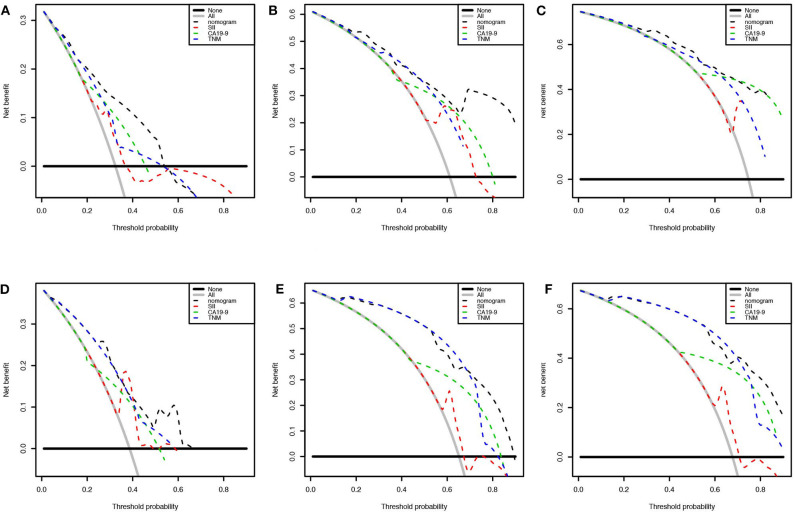
Decision curve analysis presented the clinical net benefit between different models. Nomogram was compared with the AJCC 8th edition stage system, SII, and CA 19-9 of 1 (A), 3 (B), and 5 years (C) in the training cohort and 1 (D), 3 (E), and 5 years (F) in the validation cohort. The horizontal solid black line represented the assumption without any event. The solid gray line represented the assumption that all patients would experience the event. The dashed line showed the net benefit of models (black: nomogram, red: SII, green: CA 19-9, blue: AJCC 8th edition stage system).